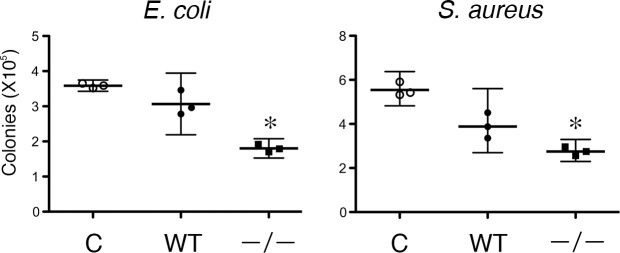
Antimicrobial activities of epidermal extracts.CFU ability was assayed in the presence of 5 mM MOPS buffer (control) (C), an epidermal extract from wild-type mice (WT) or an epidermal extract from Tgm1–/–mice (–/–) (19.5 dpc pups, n = 3). Dilutions of the extracts were 1/100 and 1/1000 for E. coli and S. aureus, respectively. Killing activities against both types of bacteria were more pronounced in the epidermal extract from Tgm1–/–mice than that from wild-type mice. *, P<0.05 vs C and WT.